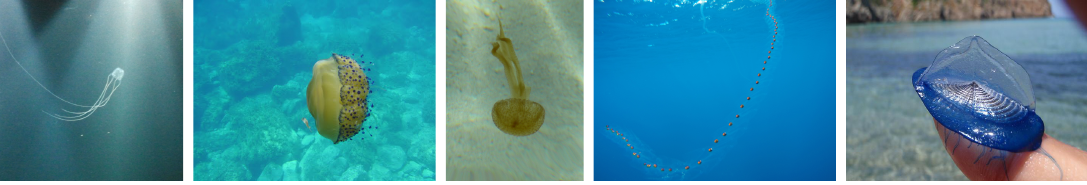
Figure 1. Images of Carybdea marsupialis , Cotylorhiza tuberculata , Pelagia noctiluca , salp and Velella velella .